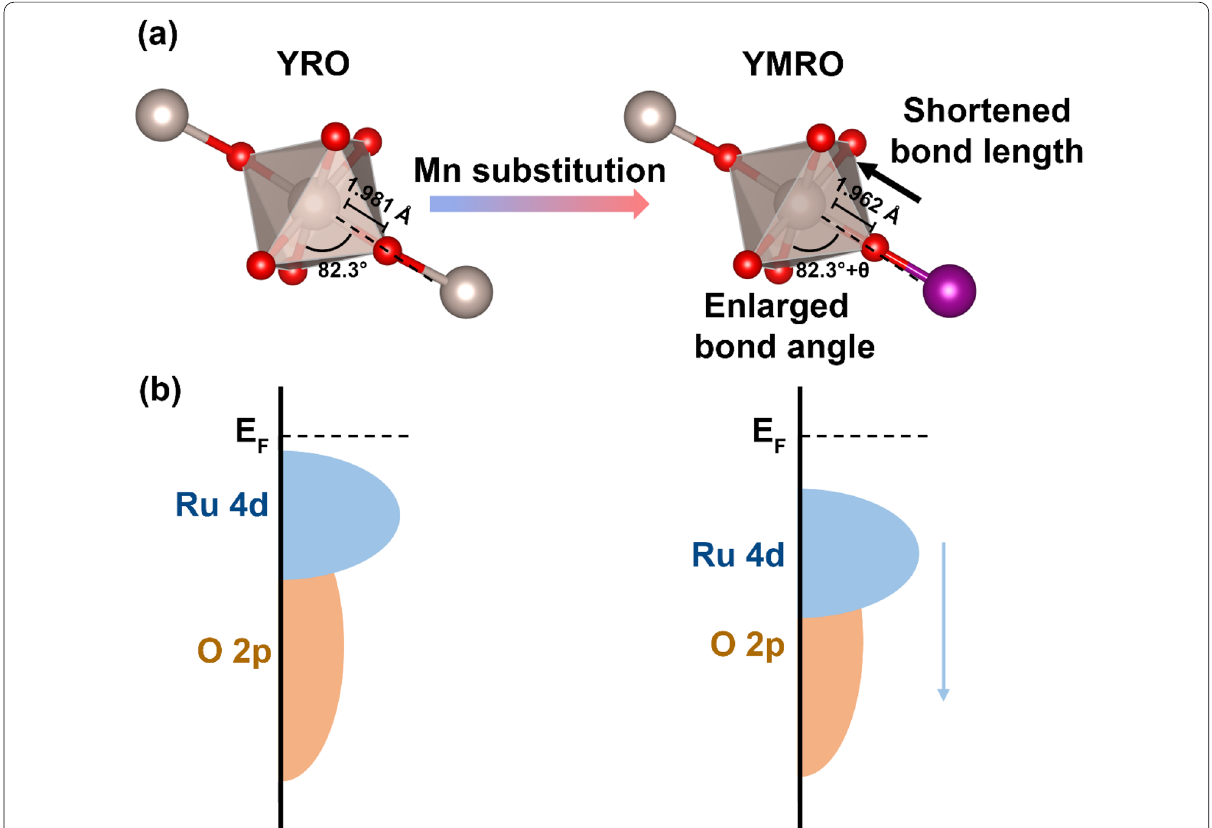
Fig. 7 Illustration of a the normal and distorted RuO 6 building blocks and b the corresponding shifts of band center of O 2p and Ru 4d